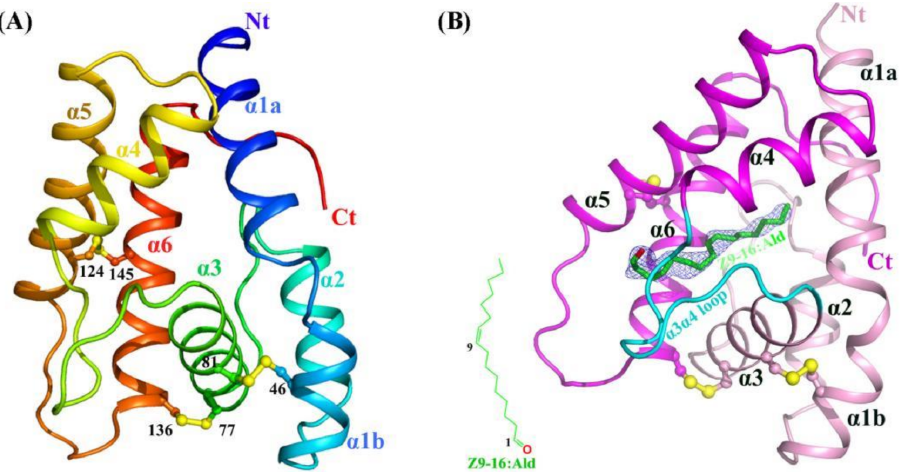
Figure 1. Crystal structures of apo and Z 9-16:Ald-bound HarmPBP1. ( A ) Ribbon representation of apo-HarmPBP1 with rainbow coloring mode. ( B ) The Z 9-16:Ald-bound HarmPBP1 structure. The chemical structure of Z 9-16:Ald (green) is shown in the bottom left. The differential electron density for the Z 9-16:Ald in a Fo-Fc map is contoured at 2.5 σ (light blue). Disulfide bridges, yellow; α 3 α 4 loop, cyan; Nt: N-terminus, Ct: